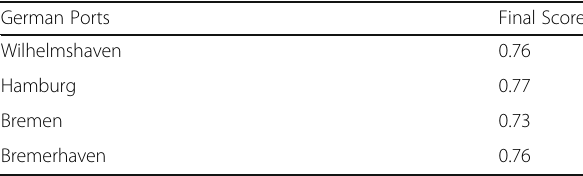
Table 4 Final score of German ports based on customers investigation weight. (Source: